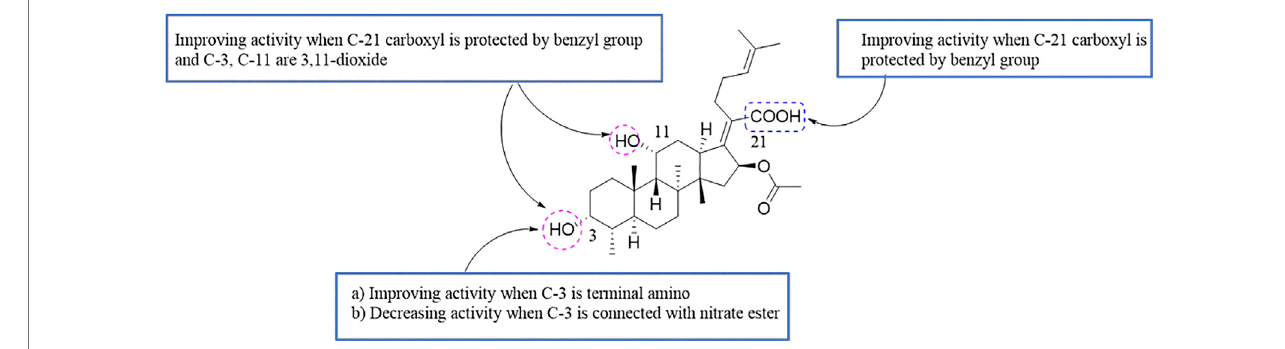
FIGURE 9 | SAR of the tumor multidrug resistance reversal activity of FA.